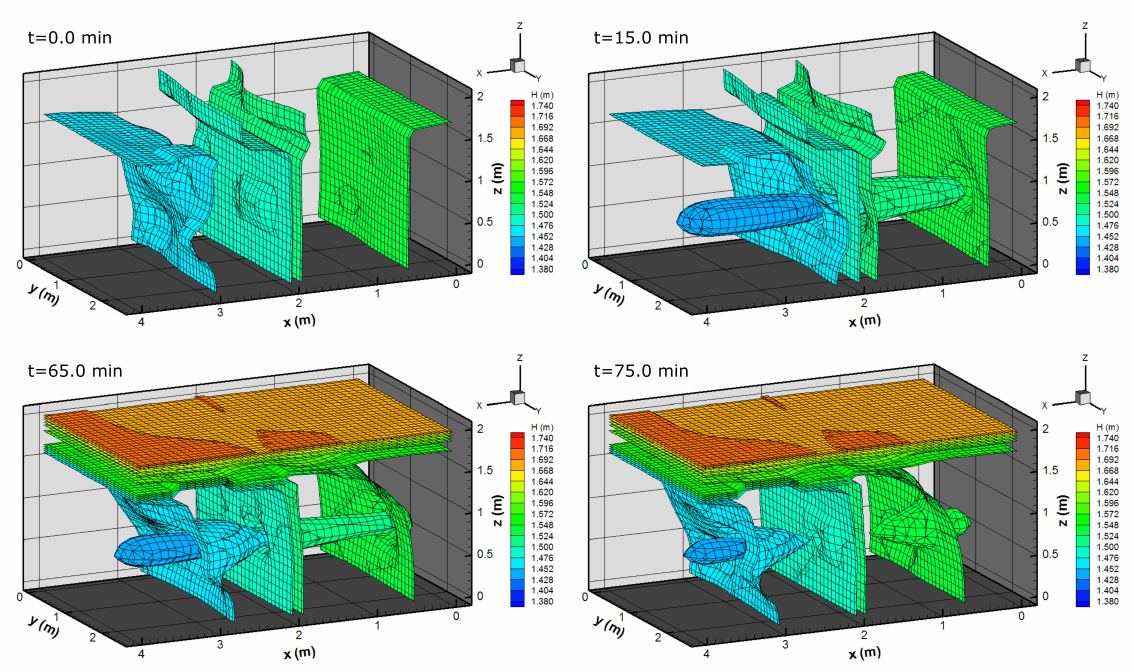
Figure 13. Contours of the matrix hydraulic head H (m) at different time